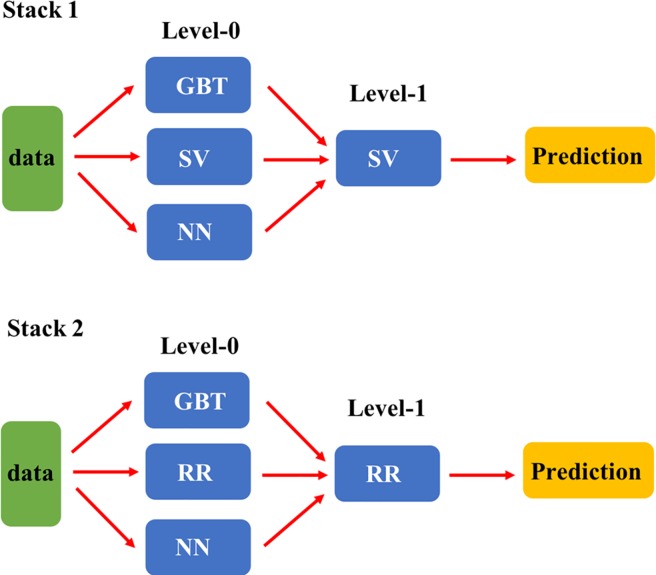
Schematic representation of the configurations of the stacked generalization frameworks (Stack 1 and 2) built from base models.SV: Support Vector Regression; RR: Ridge Regression; NN: Neural Network; GBT: Light Gradient Boosting Machine.